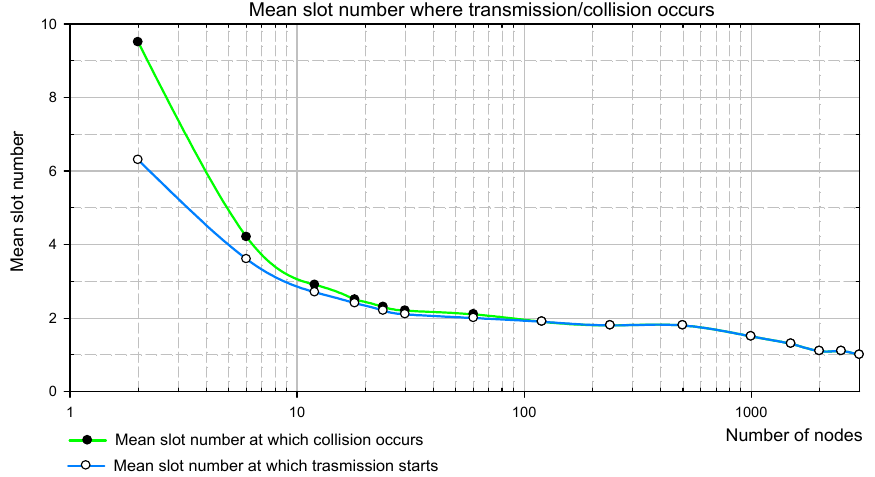
and the collision )( nd occurs for the succ coll predictive p